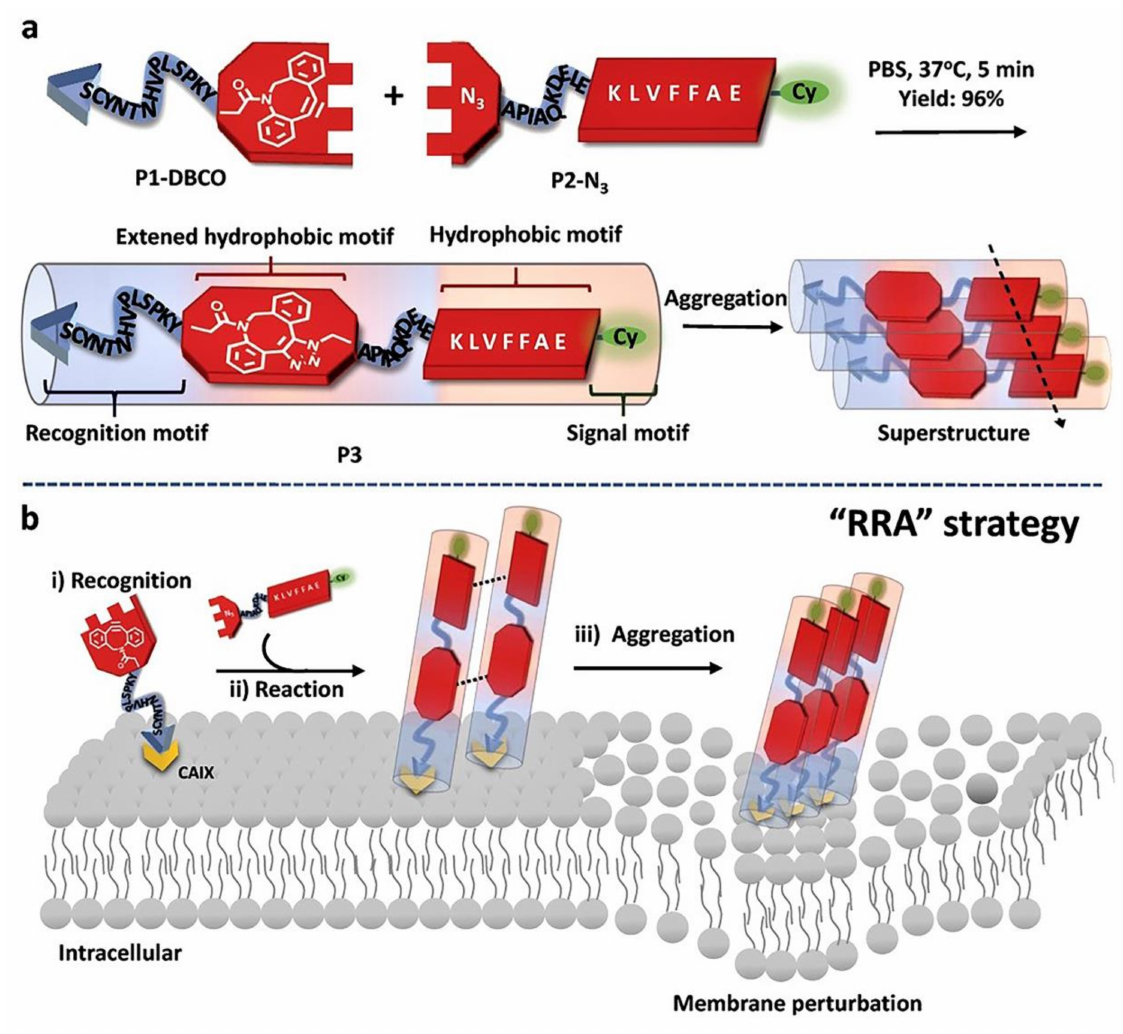
Figure 2. Schematic illustration of the molecular structure and the RRA cascade process. ( a ) The modular structure of DBCO-linked CAIX-targeting peptide (P1-DBCO) and azido-linked peptide labeled with cyanine dye (P2-N 3 ). P1-DBCO and P2-N 3 were monomeric states with hydrophilic–hydrophobic balance in aqueous solution, respectively. P2-N 3 could effectively react with P1-DBCO to form a monomer peptide P3 at 37 ◦ C for 5 min in PBS. The newly formed nitrogen heterocyclic structure of molecule P3 extended the hydrophobic unit, which broke the hydrophilic–hydrophobic balance, then accelerated aggregation to form the superstructure. ( b ) On the cellular level, P1-DBCO could specifically recognize renal cancer cells by targeting CAIX. Then, P2-N 3 was added to react with P1-DBCO to form monomer peptide P3 on the cell membrane. Meanwhile, monomer P3 will aggregate to the superstructure that achieved membrane perturbation. Reproduced with permission from [45], John Wiley and Sons,